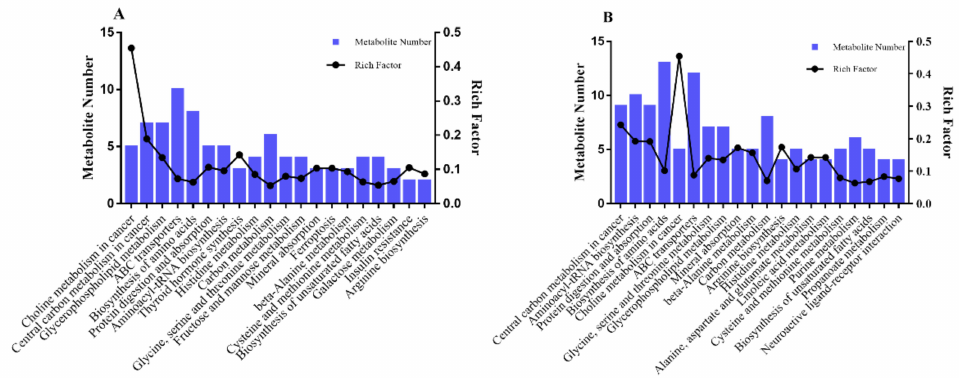
Figure 4. KEGG pathway enrichment analysis results of metabolites in the comparison of the GF and GSF groups ( A ) and the SF and GSF groups ( B ). n = 8 for each group.